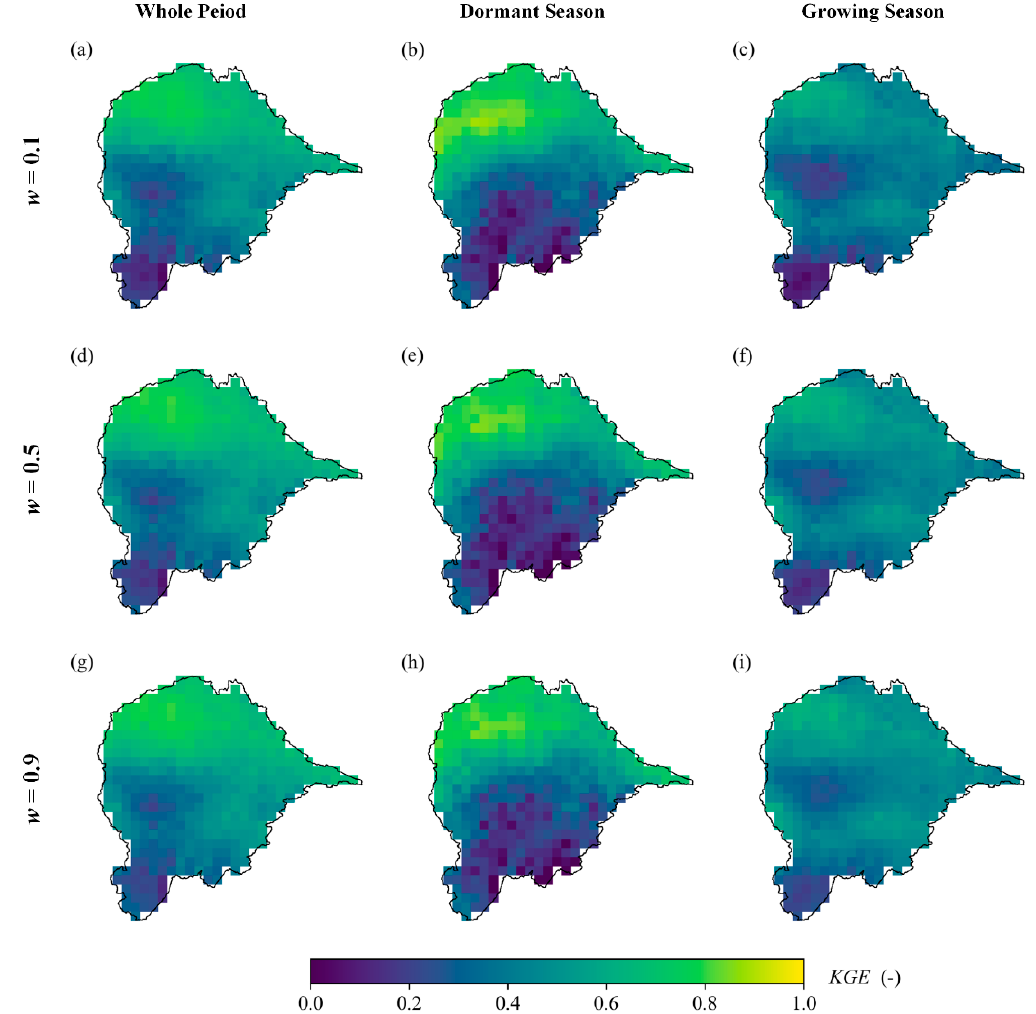
Figure 7. KGE value between cell-based SWI series ( θ SWI ) and DDRM-simulated soil moisture series ( θ DDRM ) during the whole period (the left column), the dormant seasons (the middle column) and the growing seasons (the right column) under three calibration schemes ( w = 0.1, w = 0.5, w = 0.9, respectively).